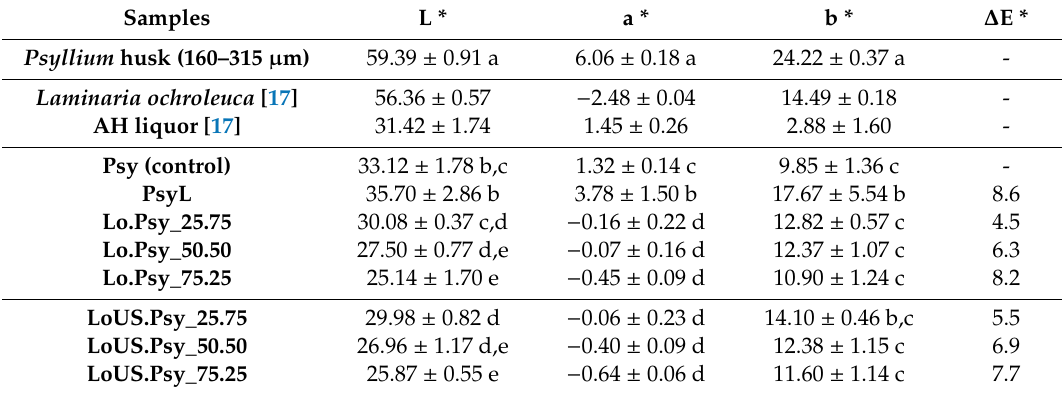
Table 2. Color parameters (L*, a*, b*) and ∆ E* of Psyllium husk, Laminaria ochroleuca and its AH liquor, and the gels developed.